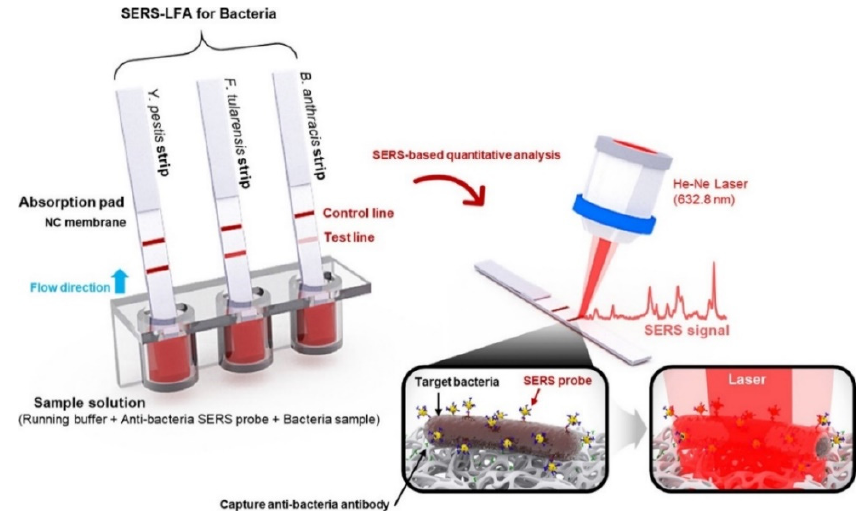
Figure 6. Principle of SERS-based sensor for bacteria detection. Republished with permission from [86]; permission conveyed through Copyright Clearance Center, Inc.